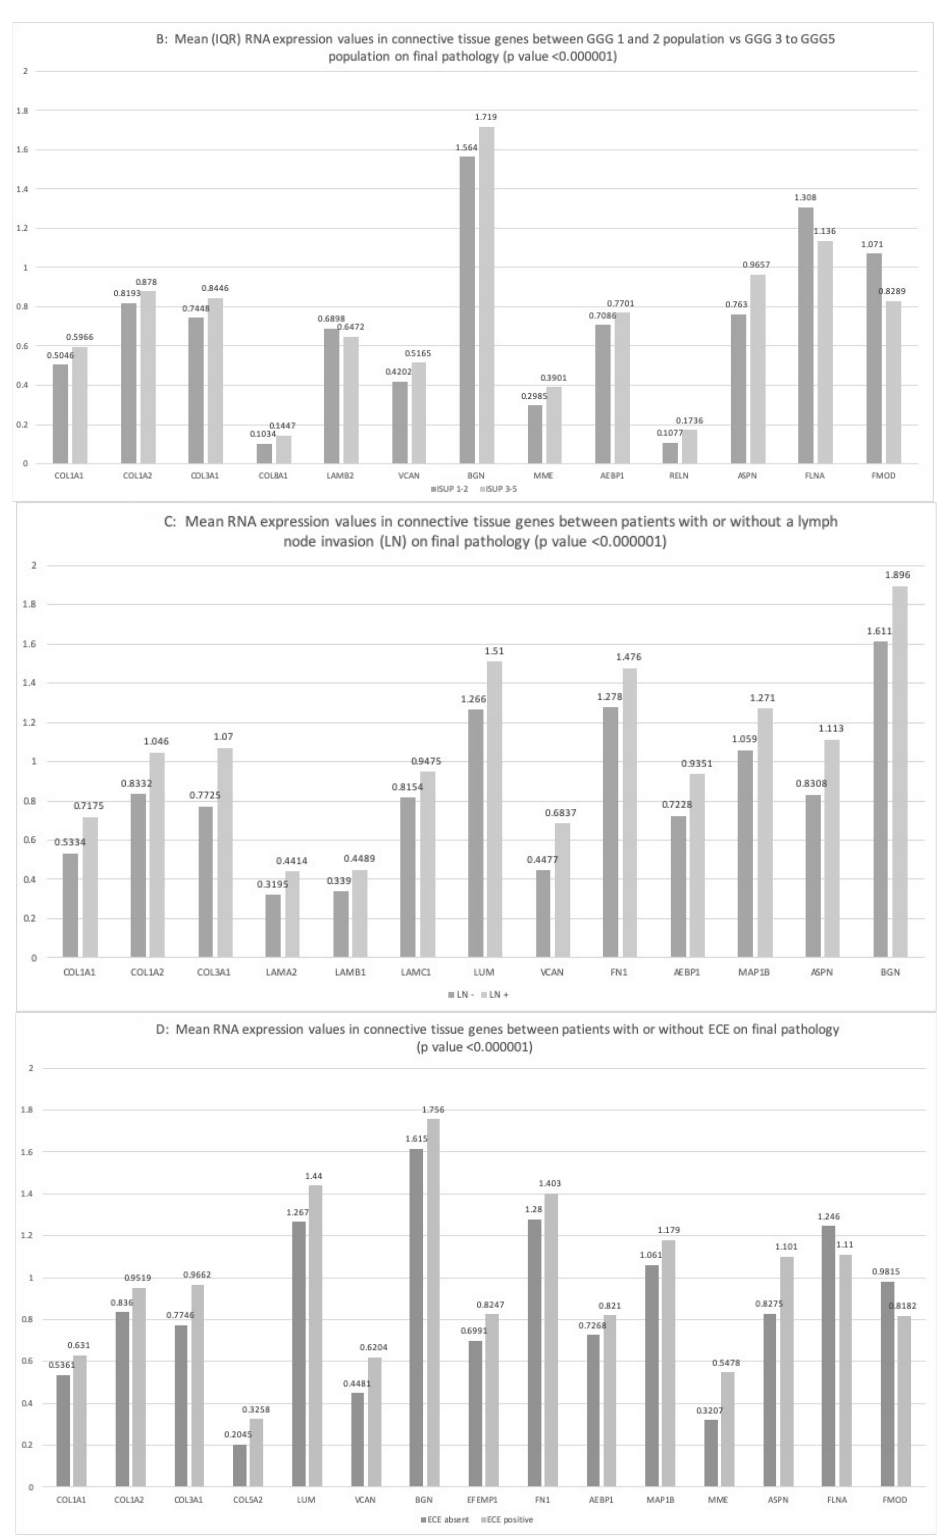
Figure 1. Transcriptomic differences in the connective tissue genes correlated with pejorative out- comes: ISUP 2 vs. ISUP 3 ( A ); ISUP 1 and 2 vs. ISUP 3 to 5 ( B ), Lymph node (LN) invasion or no lymph node invasion ( C ); Extra-capsular extension (ECE) or no ( D ). Statistically significant difference among the di ff erent values was set at p < 0.05. Mean RNA expression are in measured in IQR.